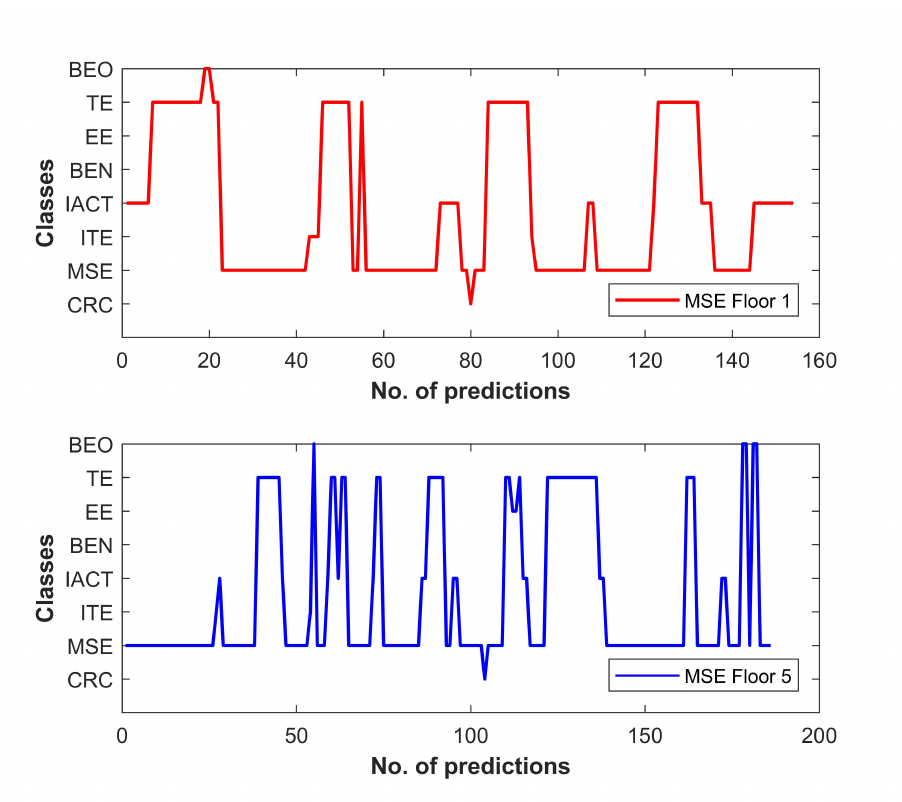
Figure 13. Predictions result using MSE building user